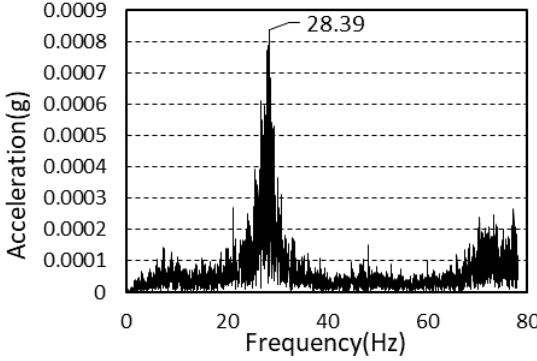
Figure 6. Power spectrum (framing completion).